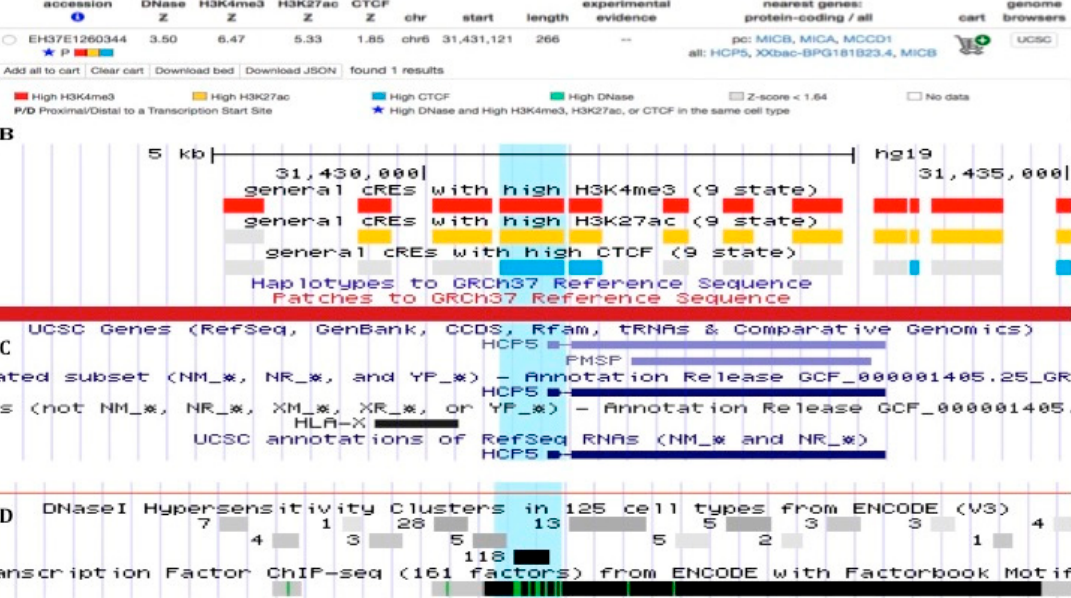
Figure 4. CTCF-binding sites proximal to and within the HCP5 gene. ( A ) ENCODE accession number (EH37E1260344) and statistical scores for presence of binding sites for CTCF, H3K4me3, and H3K27ac and DNaseI hypersensitivity clusters. ( B ) The ENCODE regulation tracking details from the UCSC genome browser (Table S1) show the CTCF locations (blue horizontal blocks on line 3) relative to ( C ) the HCP5 and HLA-X gene positions below the horizontal red line. In ( B ) the cREs with a high probability for binding H3K4me3 are the red blocks on line 1, and those with high probability for binding H3K27ac are the yellow blocks on line 2. ( D ) The location of the DNaseI hypersensitivity clusters and 161 transcription factor binding sites from ChIP-seq data analysis archived in ENCODE are shown below the HLA-X and HCP5 genes.